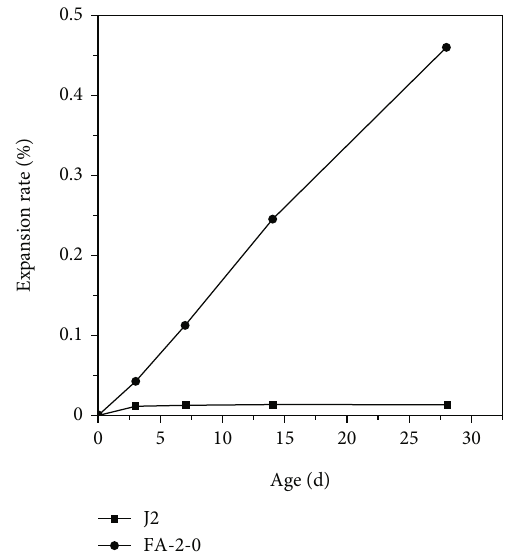
Figure 5: The diagram between FA-2-0 benchmark specimen and age.